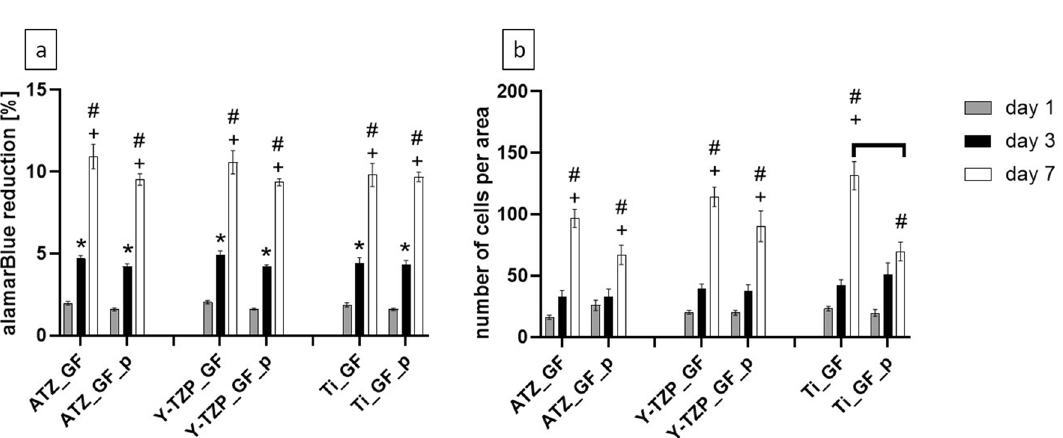
Figure 13. Metabolic activity ( a ) and total cell number per area determined by counting the cells on micrographs ( b ). The percentage of alamarBlue reduction in the supernatant refers to a 100% reduced control. Data are presented as mean values ± SEM (data collected on 6 biomaterial discs). Statistically significant differences between the different biomaterial groups were marked with brackets above the corresponding bars. “*” marks statistically significant differences between day 1 and 3, “+” between day 3 and day 7 and “#” between day 1 and day